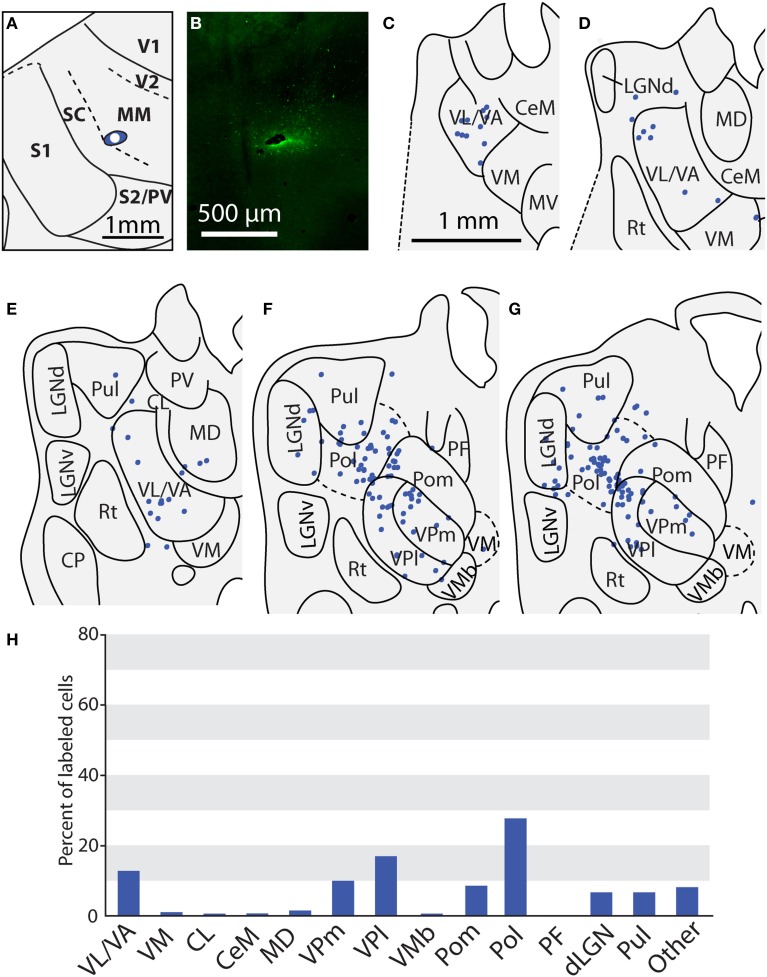
Thalamic projections to multimodal region (MM) in case 08-80. (A) Injection site of FE in MM. (B) Fluorescent image of the FE injection site and surrounding halo. (C–G) Labeled neurons can be seen projecting to MM from large portions of VL/VA as well as from VPl and VPm. Additionally, densely packed label neurons are observed in Pol; moderate numbers of labeled neurons in LGNd and Pul. (H) Percent of labeled thalamic neurons projecting from various thalamic nuclei to MM. Conventions as in previous figures.